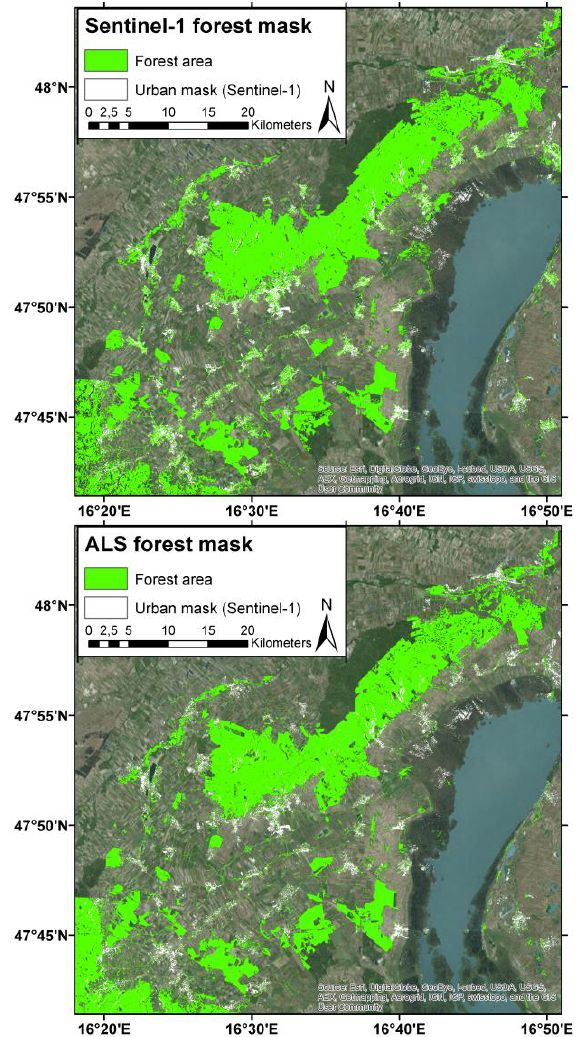
Figure 5: The ALS and Sentinel-1 (thresholding approach) forest mask for the entire region of interest overlaid on the ArcGIS Online basemap